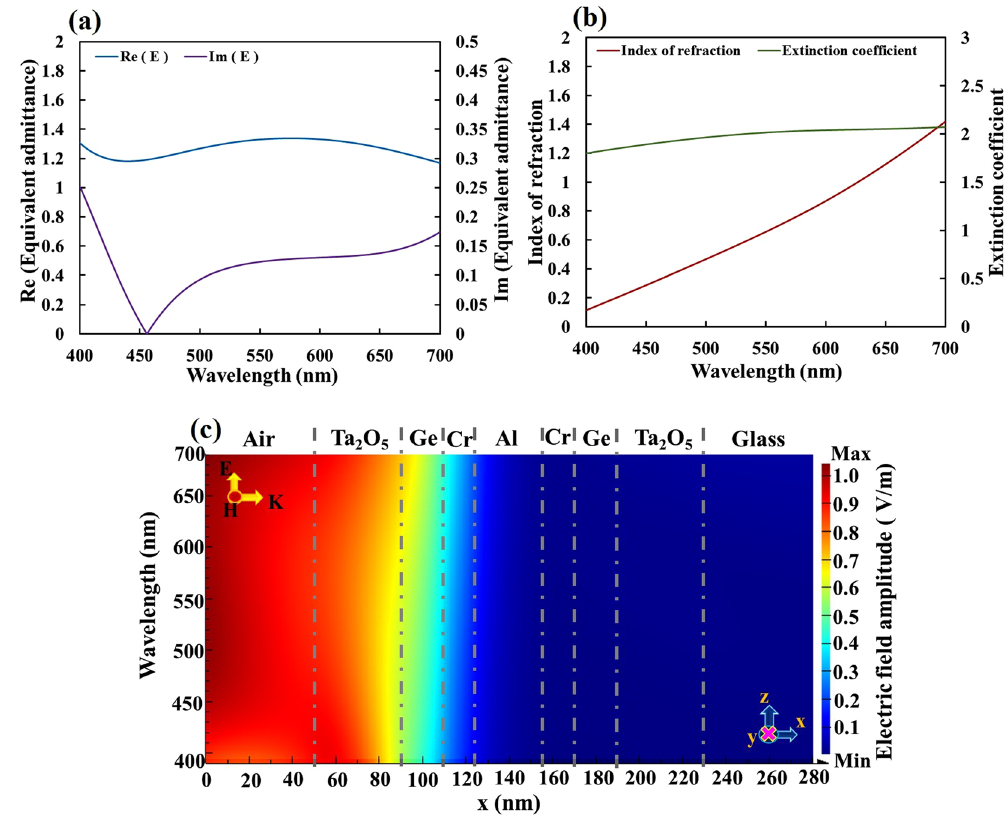
Figure 9. ( a ) Equivalent admittance, ( b ) equivalent refractive index, and ( c ) Electric field amplitude as function of